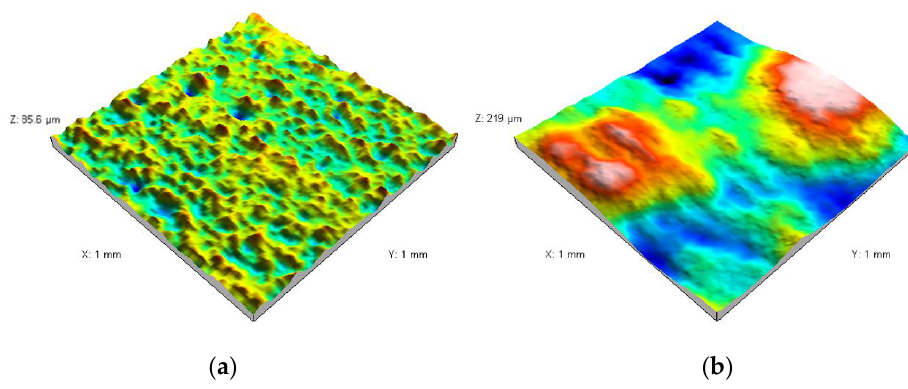
Figure 6. The surface of the sterile coupon ( a ) and coupon with biofilm ( b ).